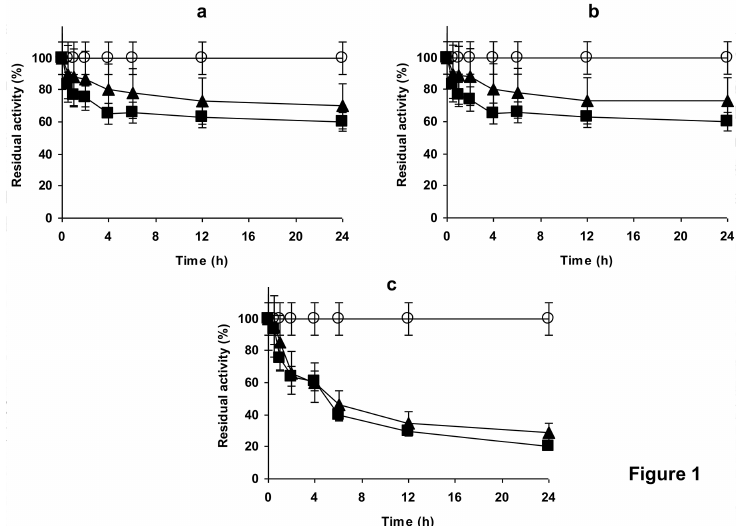
Figure 1. Immobilization of ficin extract on MANAE-agarose beads at pH 5 ( a ), 7 ( b ) or 9 ( c ). Immobilization was performed as described in methods. Activity was followed using BANA as substrate. Circles: reference; Triangles: suspension, Squares: supernatant.